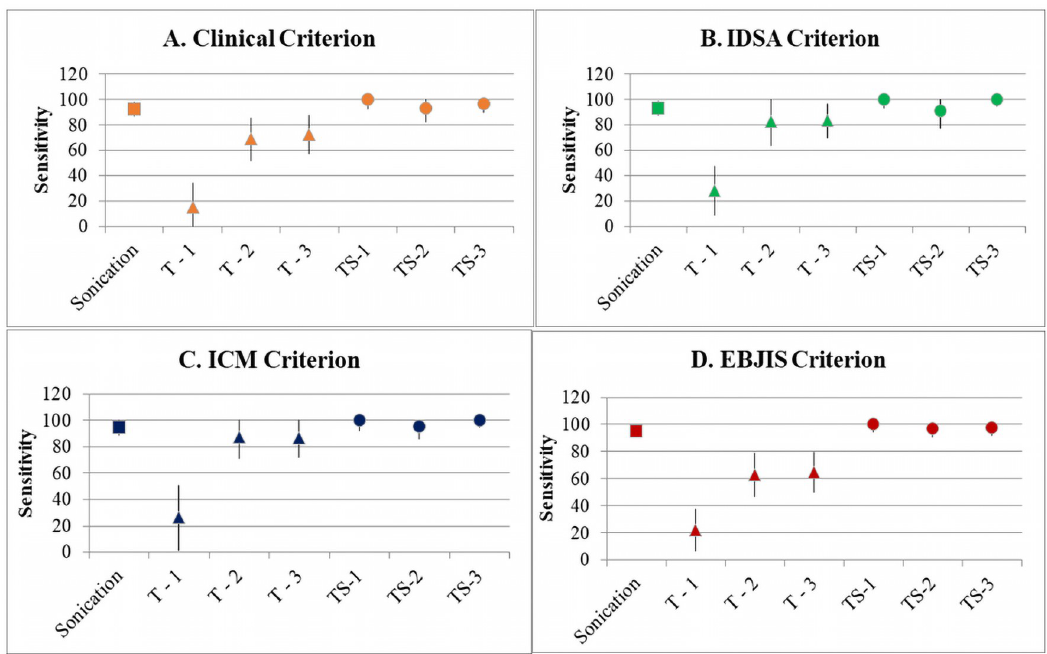
Fig 1. Sensitivity of sonication (S), tissue cultures (T) and tissue plus sonication (TS) for the following diagnostic criteria and according to number of tissue samples collected. Diagnostic criteria: clinical modified (A), IDSA (B), ICM (C) and EBJIS (D). Number of tissue samples collected: 1: 2–4 tissue samples; 2: 5–7 tissue samples; 3: � 8 tissue samples. PJI: prosthetic joint infection; ICM: International Consensus Meeting; IDSA: Infectious Diseases Society of America; EBJIS: European Bone and Joint Infection Society.